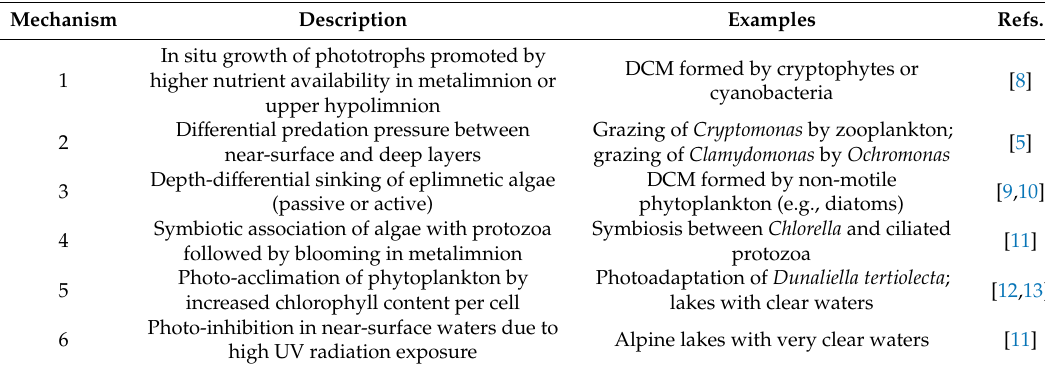
Table 1. Summary of mechanisms proposed for deep chlorophyll maxima (DCM) formation in lakes worldwide (taken from